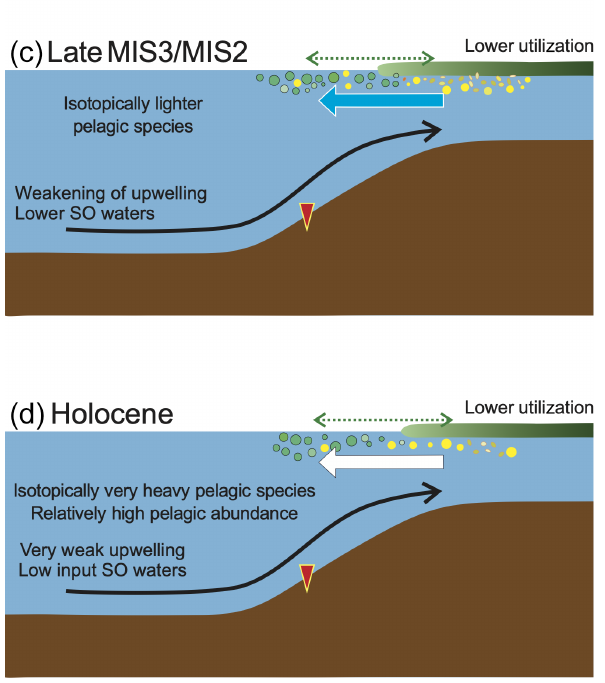
Figure 4. Schematics of Si cycling in the BUS at each time inter- val of the GeoB3606-1 record: (a) MIS4; (b) early MIS3; (c) late MIS3–MIS2; (d) MIS1 (Holocene). Full circles represent valves of A. curvatulus and C. radiatus , whereas small elliptic forms repre- sent resting spores of Chaetoceros . Blue arrows represent the move- ment of DSi-rich surface waters; white arrows represent the move- ment of DSi-poor surface waters. See the main text for a